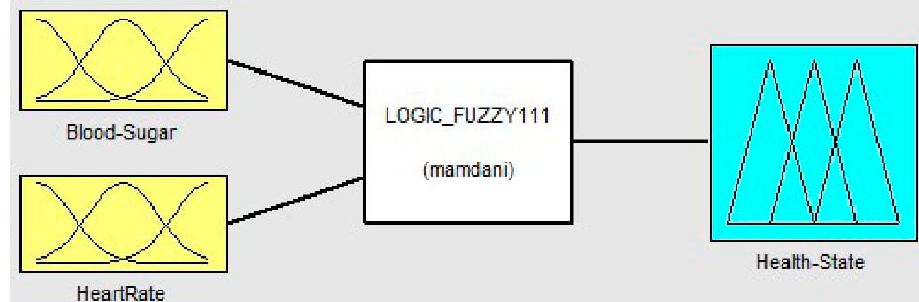
Figure 2. Overview of Fuzzy Logic System. Table 1. Inputs for fuzzification. Blood Sugar Low, Normal, Prediabetic, Diabetic Heart Rate Bradycardia, Normal,